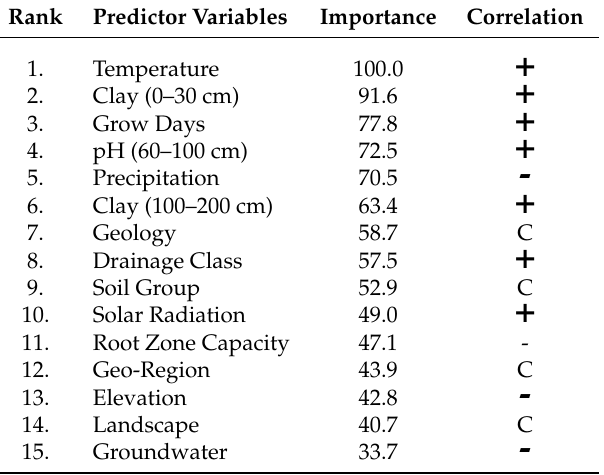
Table 2. Top 15 predictors ordered by importance in the random forest model using permutation as the method to determine variable importance. Correlation is indicated by a + for positive correlation, - for negative correlation, and C for categorical variable. A bold + or - indicates whether predictors are significantly correlated with winter wheat yield (linear regression: p -value < 0.05). Rank Predictor Variables Importance Correlation